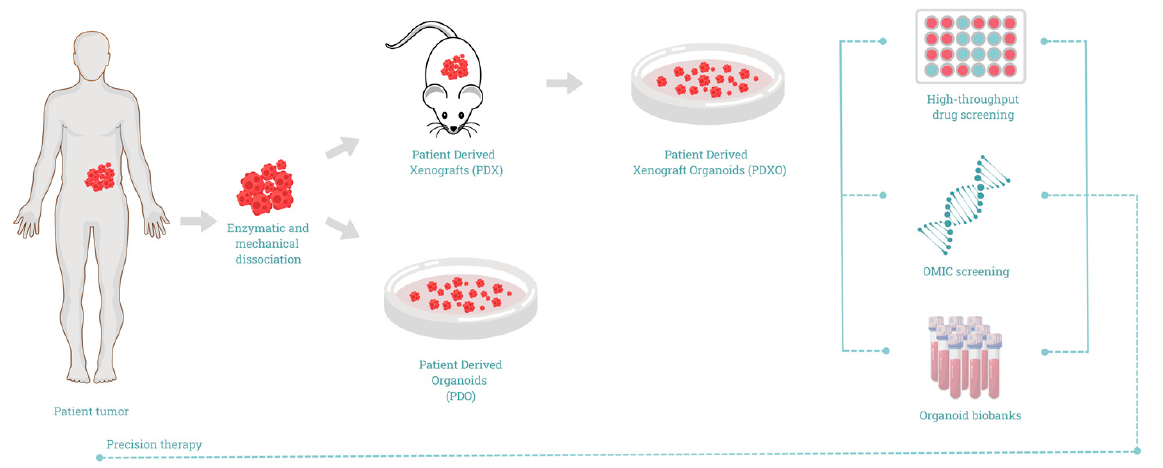
Figure 1. Schematic representation of patient-derived organoids (PDO) development for precision cancer medicine.